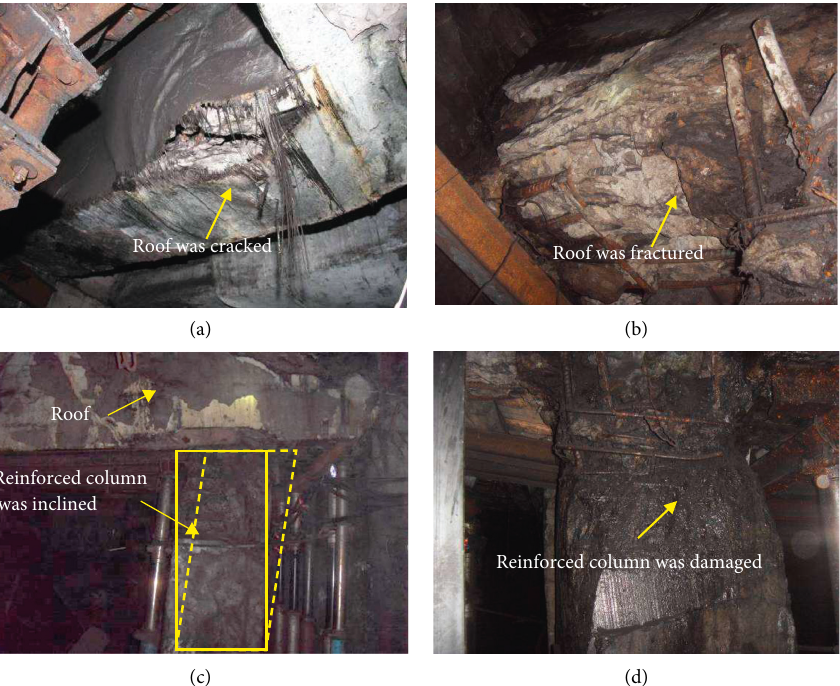
Figure 3: Collapse characteristics of the CFC in coal bunker #214. (a) The roof was cracked. (b) The roof was fractured. (c) The reinforced concrete column was inclined. (d) The reinforced concrete column was